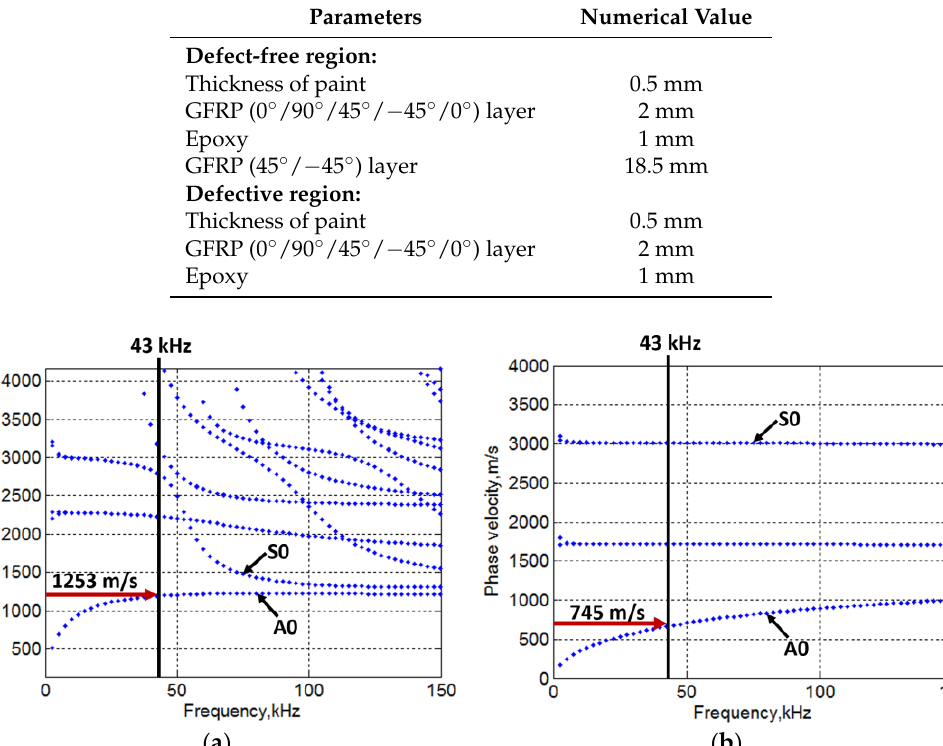
Figure 5. Phase velocity dispersion characteristics of defect-free ( a ) and defective region ( b ) by SAFE Method.